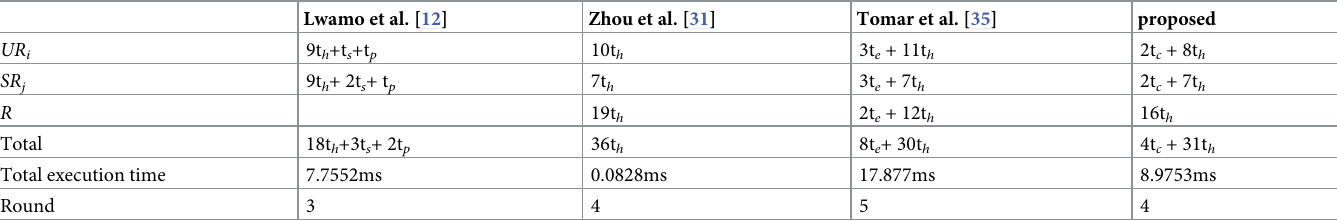
Table 4. Comparison of the computational cost between the proposed scheme and other schemes in the authentication and session key exchange phase. Lwamo et al. [12]